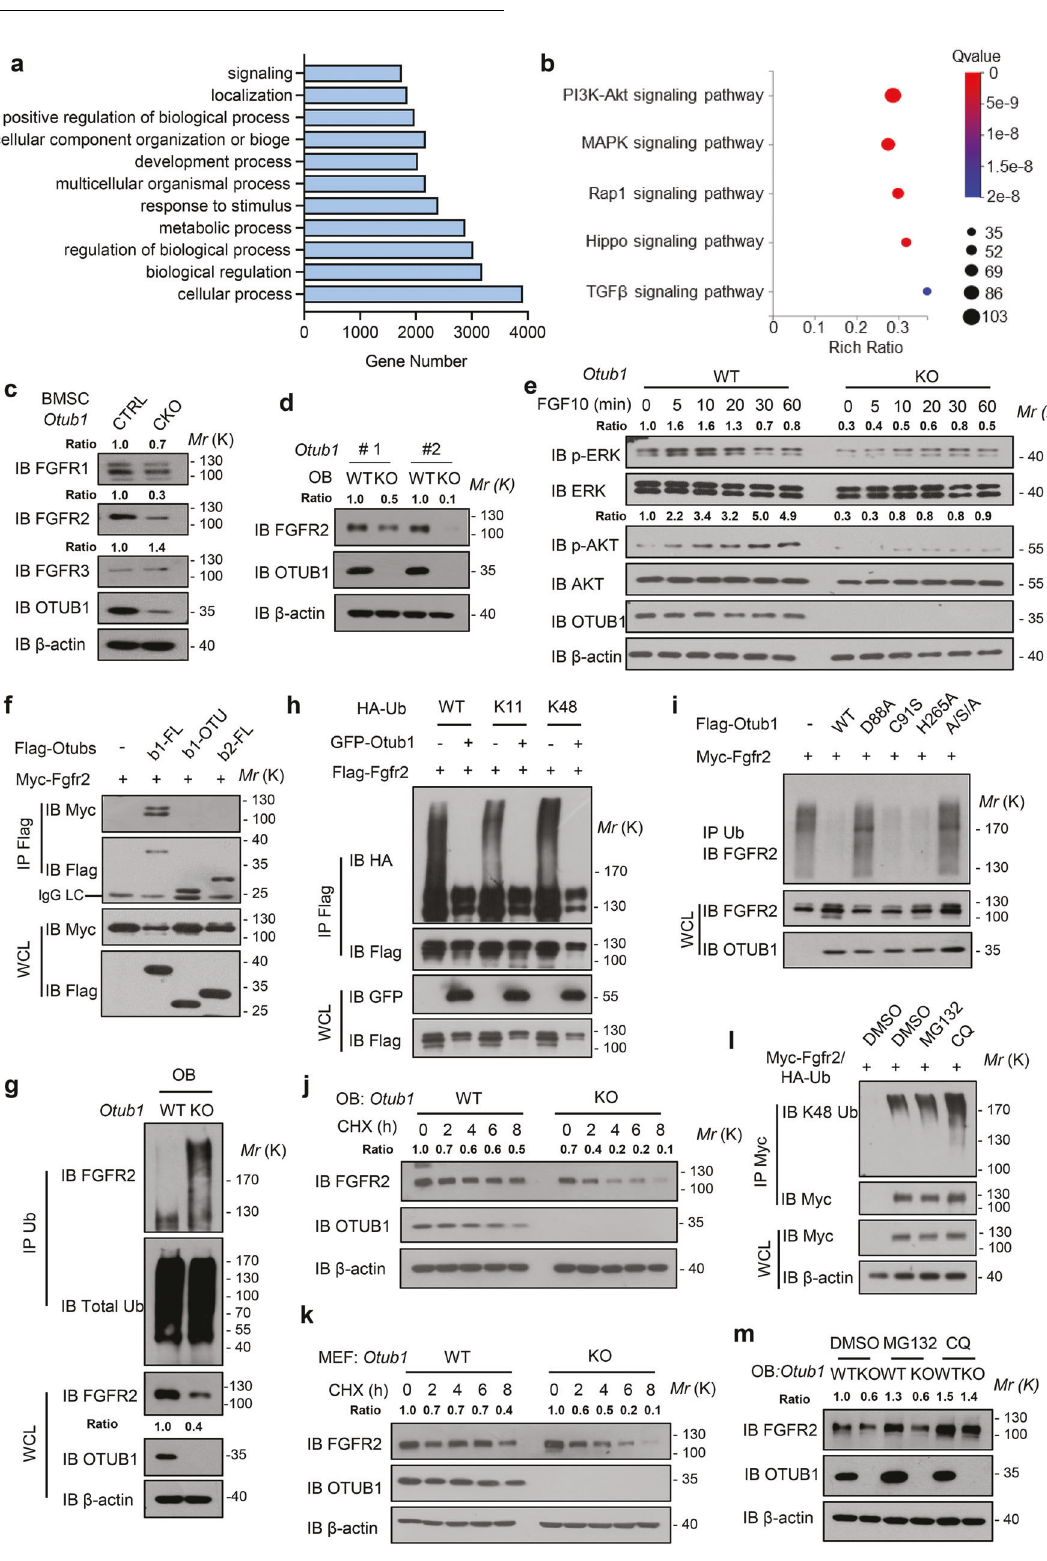
level of FGFR2 in Smurf1 knockout mouse bones. Compared with the wild-type mice, the ubiquitination of FGFR2 was decreased in the bones of Smurf1 knockout mice, whereas the ubiquitination of FGFR2 remained unchanged in the spleens (Fig. 4g and Supplementary Fig. 4e). Accordingly, FGFR2 protein level in Smurf1